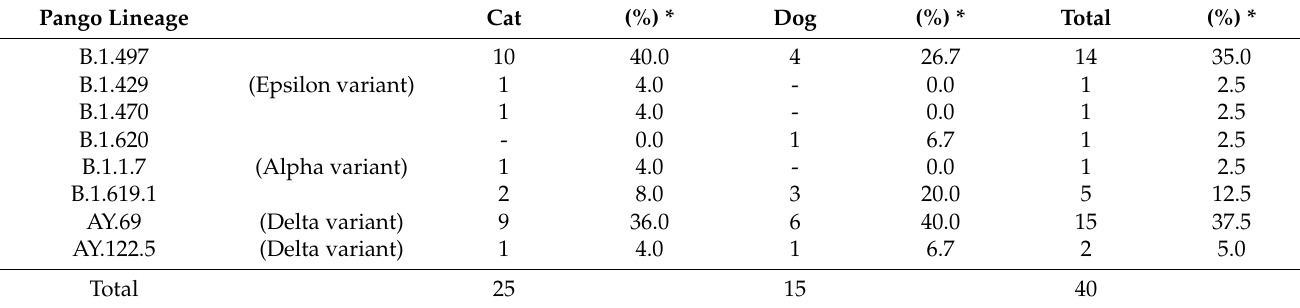
Table 1. Number of sequences of variant strains of SARS-CoV-2 in 40 animal samples.